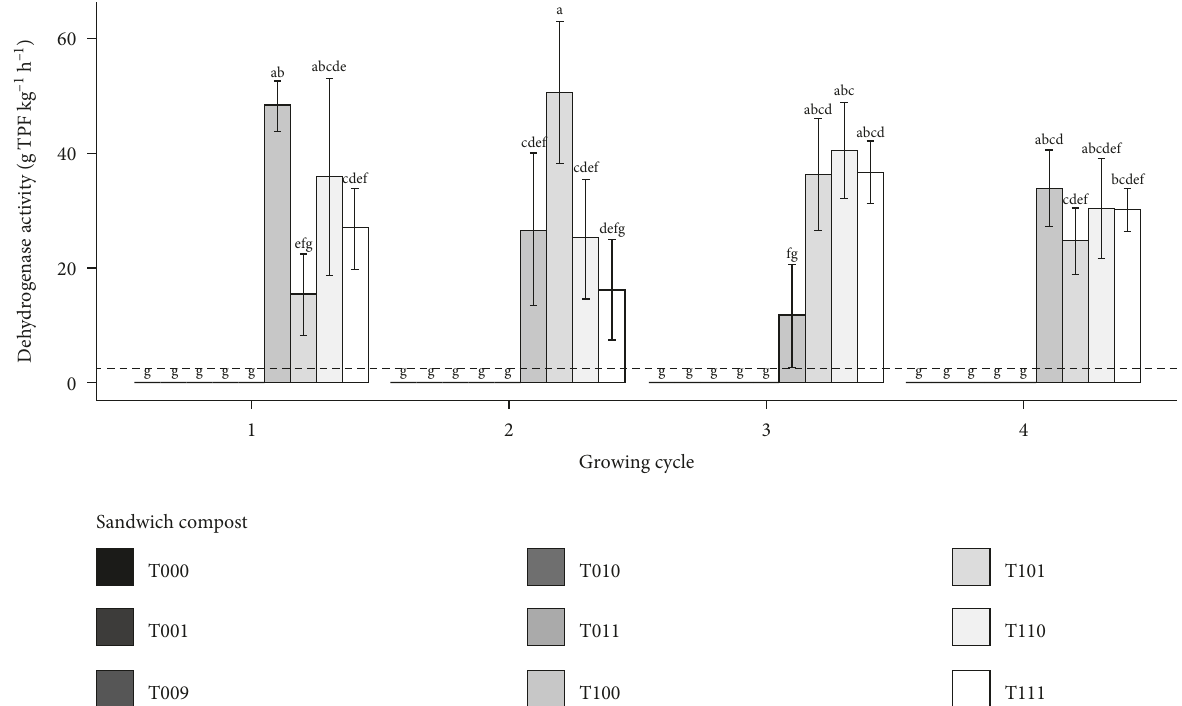
Figure 7: Effect of the growing cycle and Sandwich compost amendments on dehydrogenase activity (g TPF kg − 1 h − 1 ). Mean ± standard error with different letters is significantly different at P < 0 . 05 when using DMRT. The dotted line is referred to as the original dehydrogenase activity (2.31 ± 0.338g TPF kg − 1 h − 1 ).